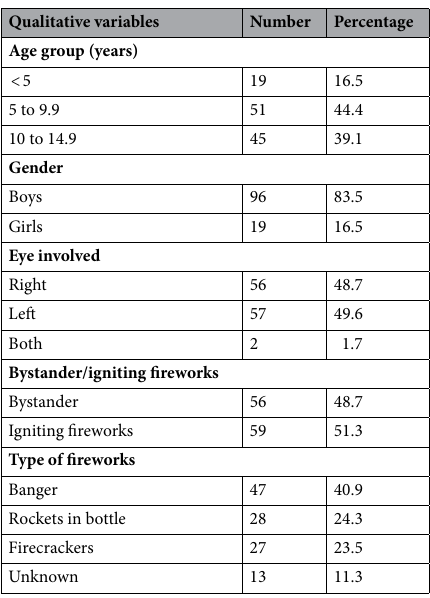
Table 1. Profile of Saudi children with fireworks-related ocular injuries.